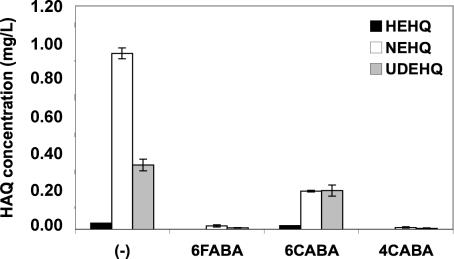
The AA Analogs Inhibit HAQ Production in B. thailandensis Cell SupernatantsMass spectrometry (MS) determination of unsaturated HAQs in OD600 = 3 culture supernatants of B. thailandensis cells grown in the absence or presence of 3 mM 6FABA, 6CABA, or 4CABA. Note that while saturated HAQs, including HHQ, occur in B. thailandensis cells, their levels were below the quantification threshold.